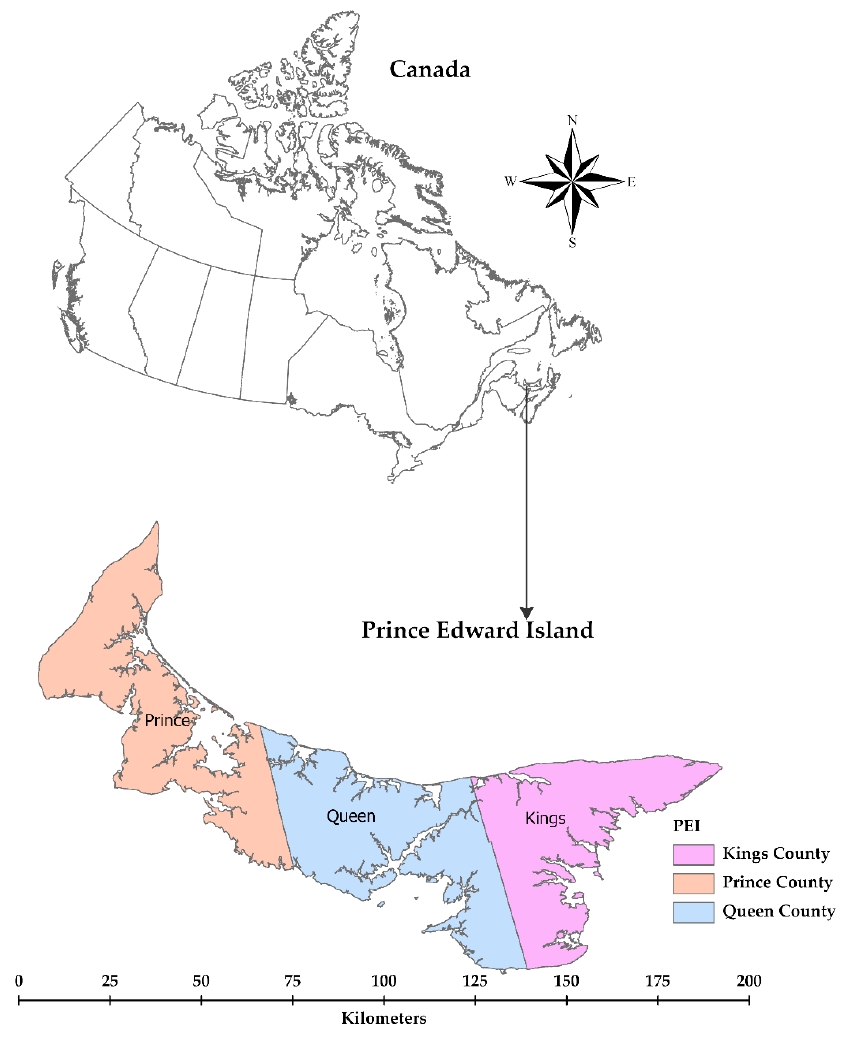
Figure 1. Prince Edward Island, Canada.